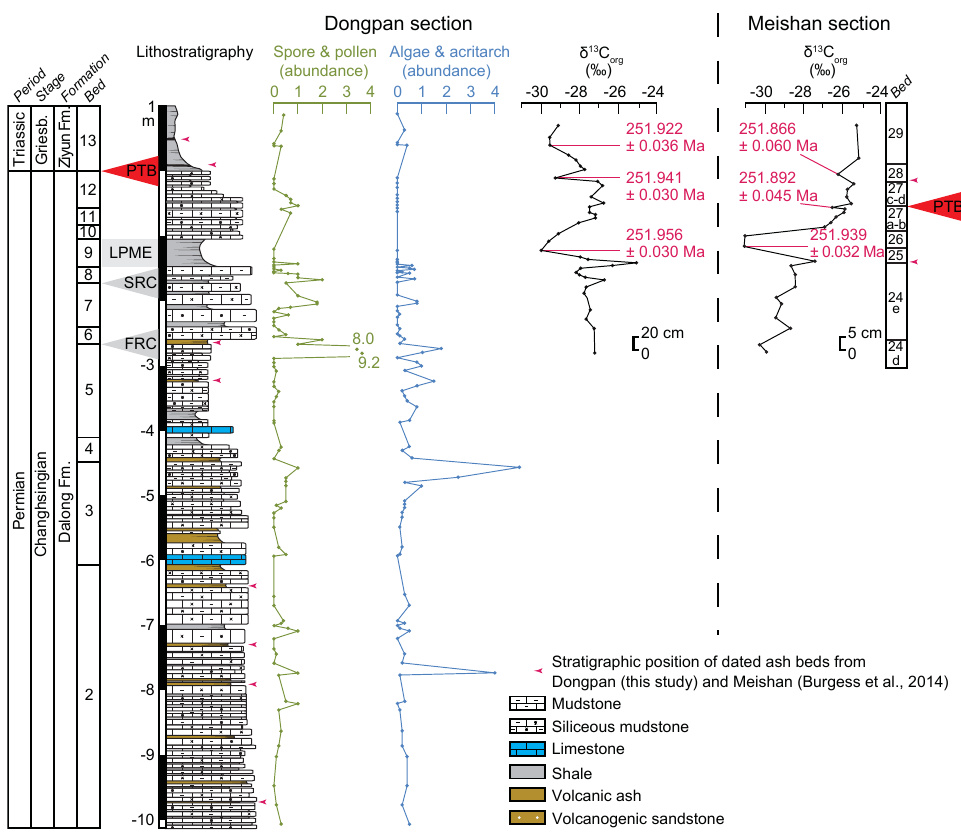
Figure 7. Comparison of the organic carbon isotope chemostratigraphy of Dongpan (Zhang et al., 2006) with that of Meishan (Cao et al., 2002). Dates and their associated uncertainty for the negative carbon isotope excursions in both sections are revealed from the Bayesian Bchron age models of Dongpan and Meishan, respectively. Abundance of spores and pollen, as well as algae and acritarchs (i.e., spores per 100cm 2 of soil) in Dongpan, is from Shen et al. (2012). Stratigraphic positions of the first radiolarian crisis (FRC) and second radiolarian crisis (SRC) (after Feng et al., 2007), the latest Permian extinction event (LPME) in Dongpan and the Permian–Triassic boundary (PTB) in both sections are indicated as well. Meishan section thickness is not to scale with the Dongpan